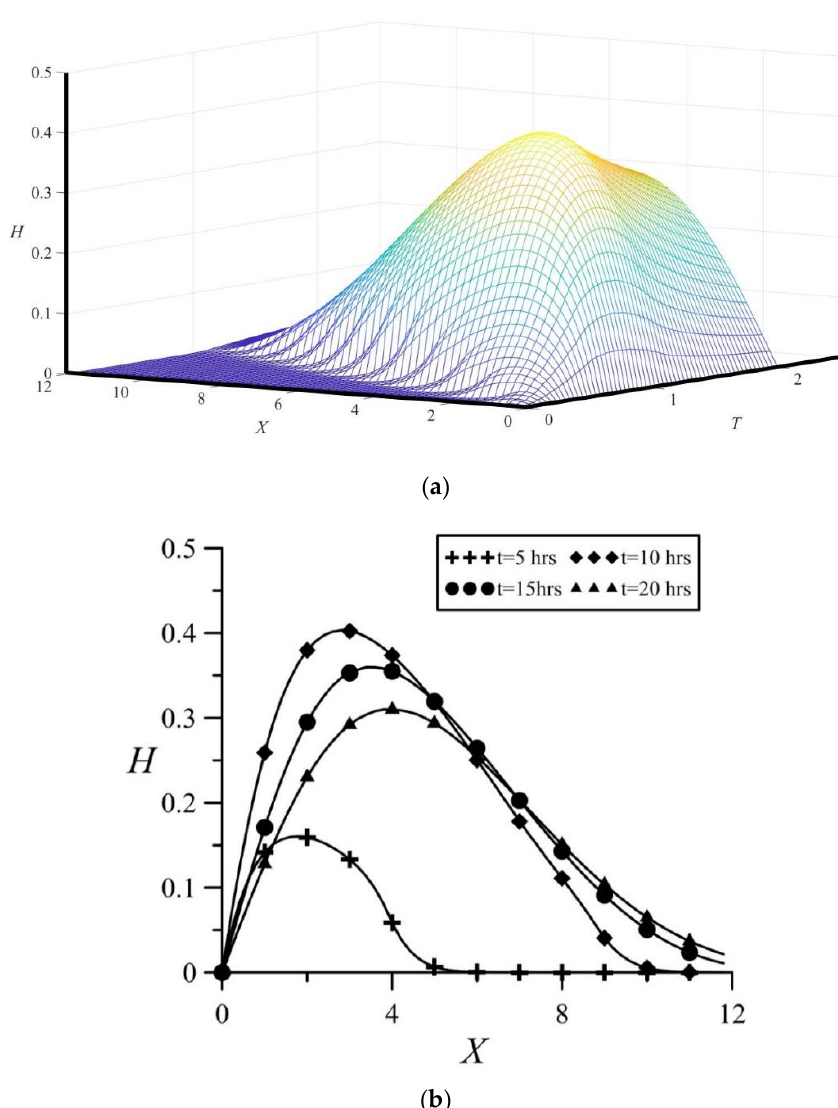
Figure 5. The effect of a unimodal rainfall event with hourly data Figure 5. The e ff ect of a unimodal rainfall event with hourly data (10, 20, 30, 40, 50, 60, 50, 40, 30, 20, 10 ( 10, 20, 30, 40, 50,60,50, 40, 30, 20, 10 mm/hr) on the groundwater level with 𝛼 = 19.6078 , 𝑈 = 0 . mm / hr) on the groundwater level with α = 19.6078, U = 0. ( a ) spatiotemporally distributed variation ( a ) spatiotemporally distributed variation of groundwater level, and ( b ) variation of groundwater of groundwater level, and ( b ) variation of groundwater level in space at some specific level in space at some specific moments.